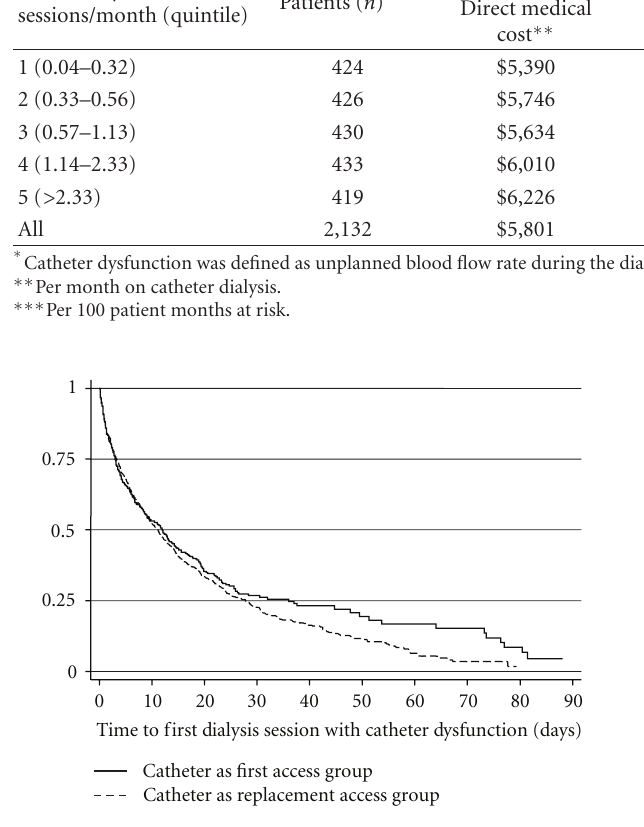
Figure 3: Rate of catheter dysfunction. Catheter dysfunction was defined as unplanned blood flow rate during the dialysis session of <